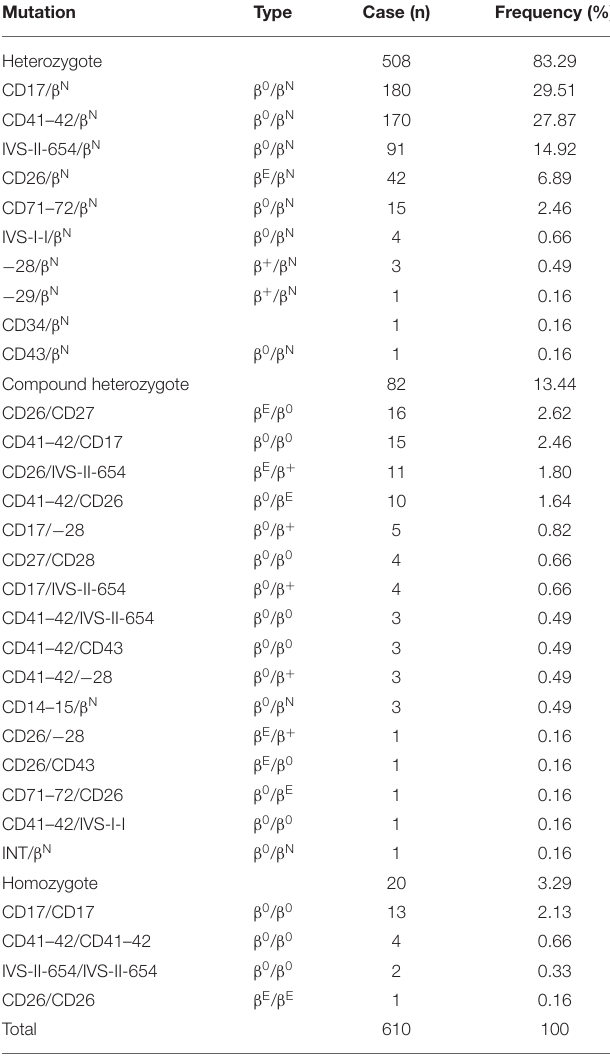
TABLE 2 | Frequency of β -thalassemia mutations in children in the Yunnan province. Mutation Type Case (n)